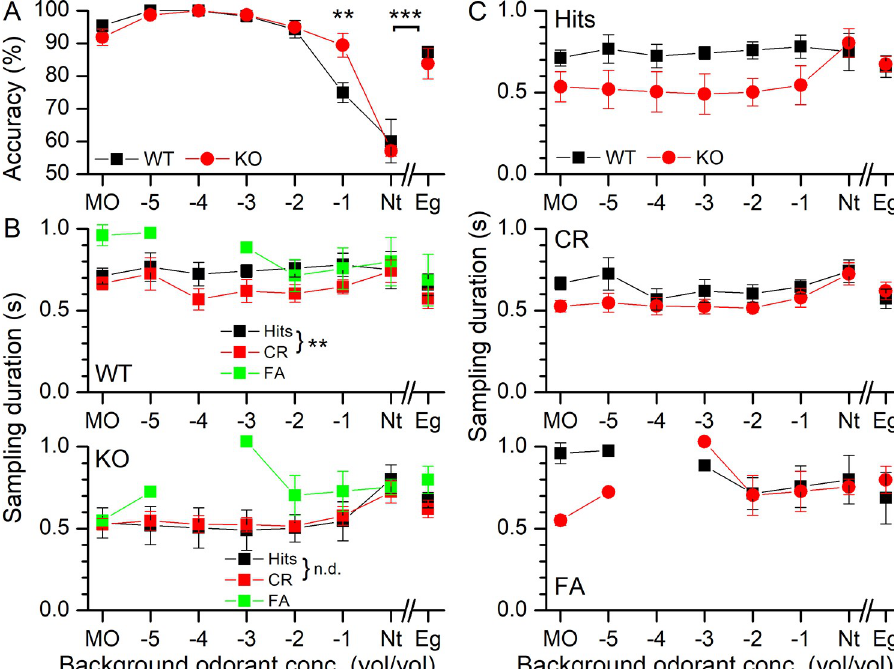
Fig 6. Accuracy and odor sampling duration in the presence of background odorants. A WT and NCKX4 mice performed a Go/NoGo task to distinguish 10 − 4 propanol from the control odor of mineral oil (MO) in the presence of increasing background concentrations of propanol up to the highest concentration of undiluted propanol (neat, Nt) and also undiluted eugenol (Eg). Accuracy with background odor present shows a significant interaction between background odor concentration and genotype. Post-hoc analysis revealed that at a concentration of 10 − 1 the odor identification accuracy is different between WT and KO with the KO having higher accuracy (p = 0.01). B The odor sampling duration as a function of the background odorant concentration for Hits, CRs and FAs for WT and KO. C Comparison of Hits, CRs and FAs between WT and KO. For sampling duration the final model has a significant 3-way interaction between behavioral outcome, genotype and background odorant concentration (F = 1.98, P = 0.03). Due to missing data points for FAs, FAs could not be estimated in post-hoc (Tukey) comparisons while for CR and Hits sampling duration in CR is shorter than for Hits in the WT (p = 0.0093) while no differences were seen between CR and Hits in the KO (p = 0.8393). Sampling durations in the CRs are very similar for WT and KO while Hits tend to be longer in WT (p = 0.0582). Data points are averages ± SEM of 3 WT and 4 KO mice. The x-axis displays the log of the odorant concentration. Round brackets indicate differences across behavioral outcome, while square brackets denote evaluation across concentration (or